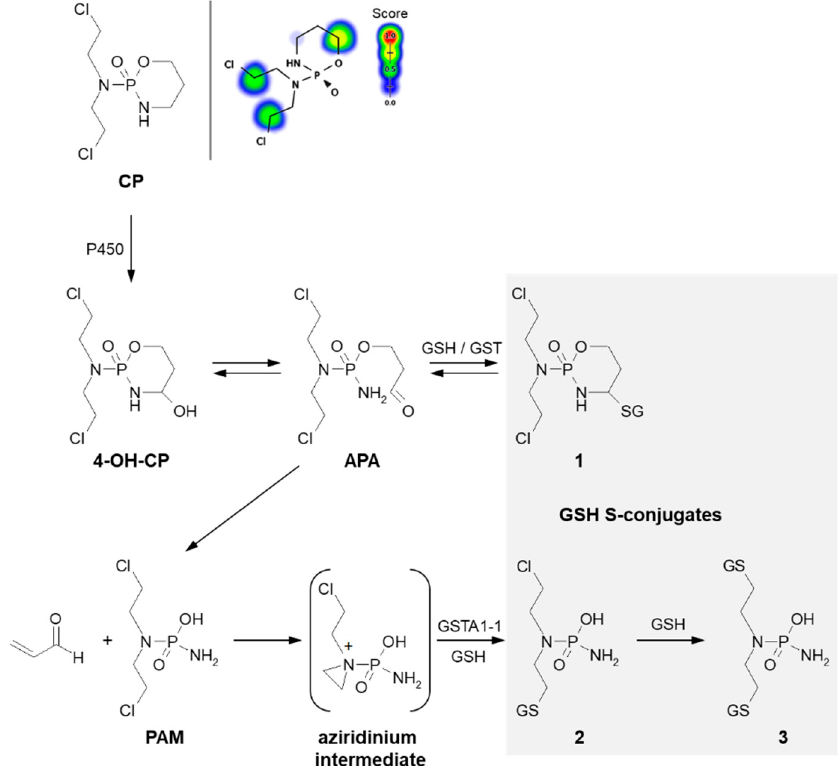
Figure 7. Scheme of cyclophosphamide (CP) activation and drug reaction with GSH [74]. Possible GSH S-conjugates: 1 : 4-monoglutathionyl cyclophosphamide, 2 : monoglutathionyl phosphoramide mustard, 3 : diglutathionyl phosphoramide mustard. 4-OH-CP = 4-hydroxycyclophosphamide; APA = aldophosphamide; PAM = phosphoramide mustard; P450 = cytochrome P450. Predicted bioactive